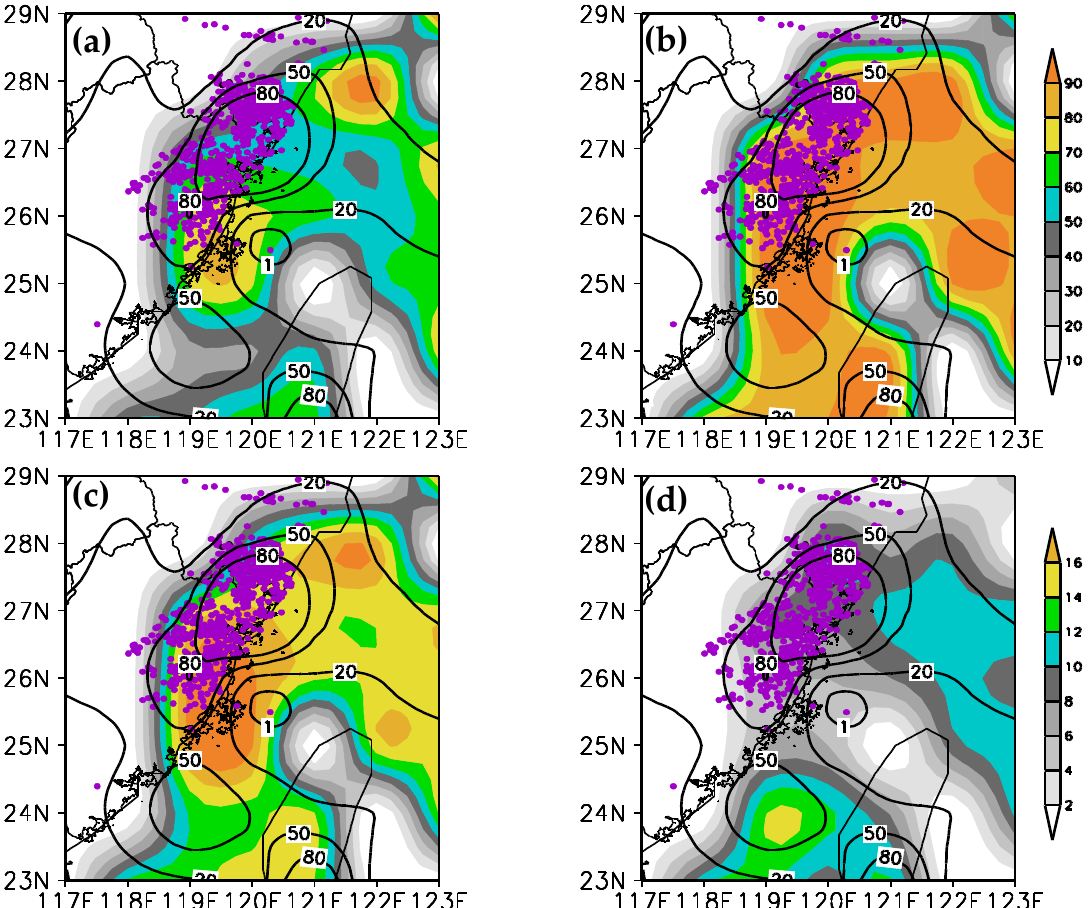
Figure 8. Comparison of the predicted 24-h SDHR probability (shaded) valid at 20:00 BT on 8 August 2015; ( a ) is for the maximum SCI group with weights of No. 1 in Table 4, ( b ) is for the maximum SCI ave group with weights of No. 6 in Table 4, ( c ) is the average of the 84 groups, and ( d ) is the corresponding standard deviation of ( c ). The available SDHR observations reported by AWS from 17:00 to 23:00 BT on 8 August 2015 are shown as purple dots. The solid lines in each panel are the NCEP-GFS-predicted six-hour rainfall accumulation (mm) from 17:00 to 23:00 BT on 8 August 2015.